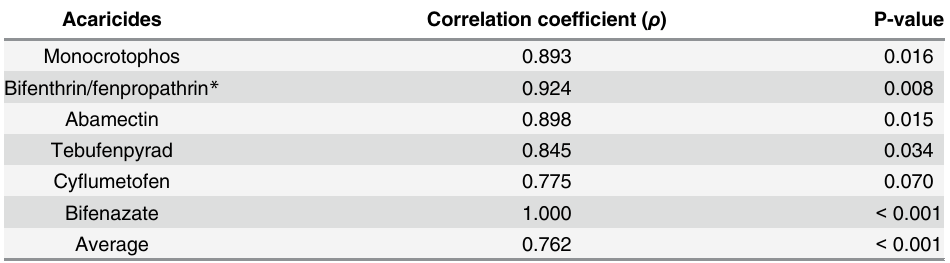
Table 4. Correlation coefficients between the mortalities obtained by RCV with diagnostic doses and those obtained by spray with recommended doses of six representative acaricides.